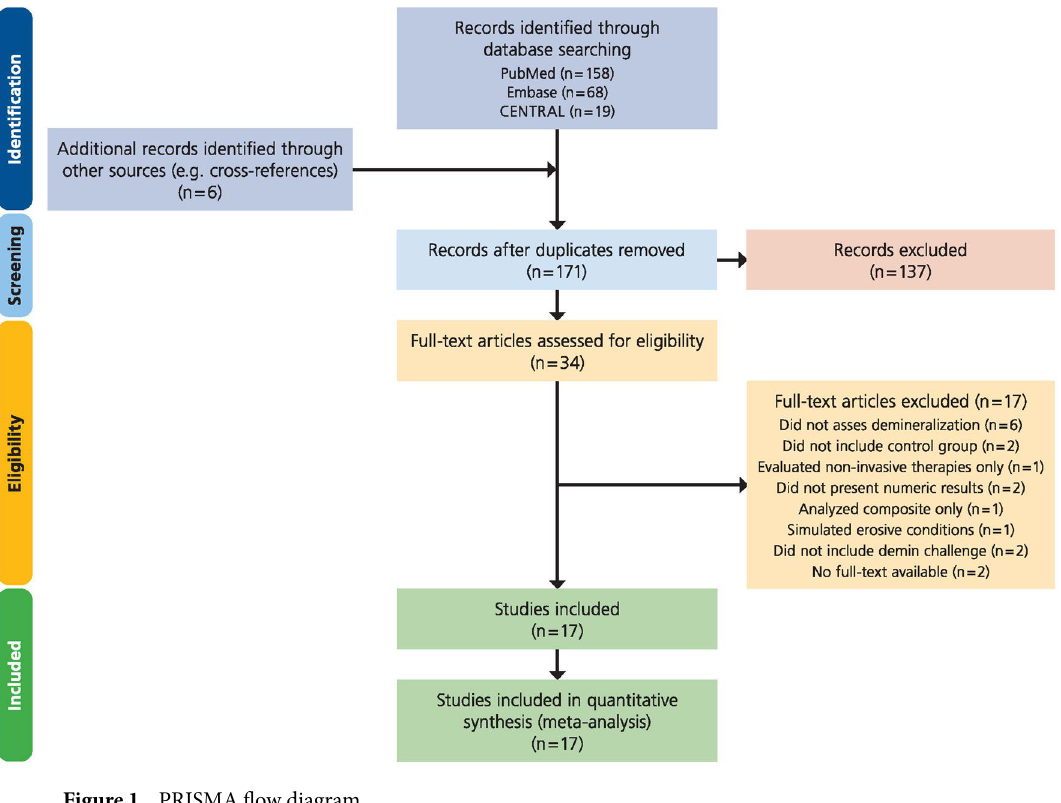
Figure 1. PRISMA flow